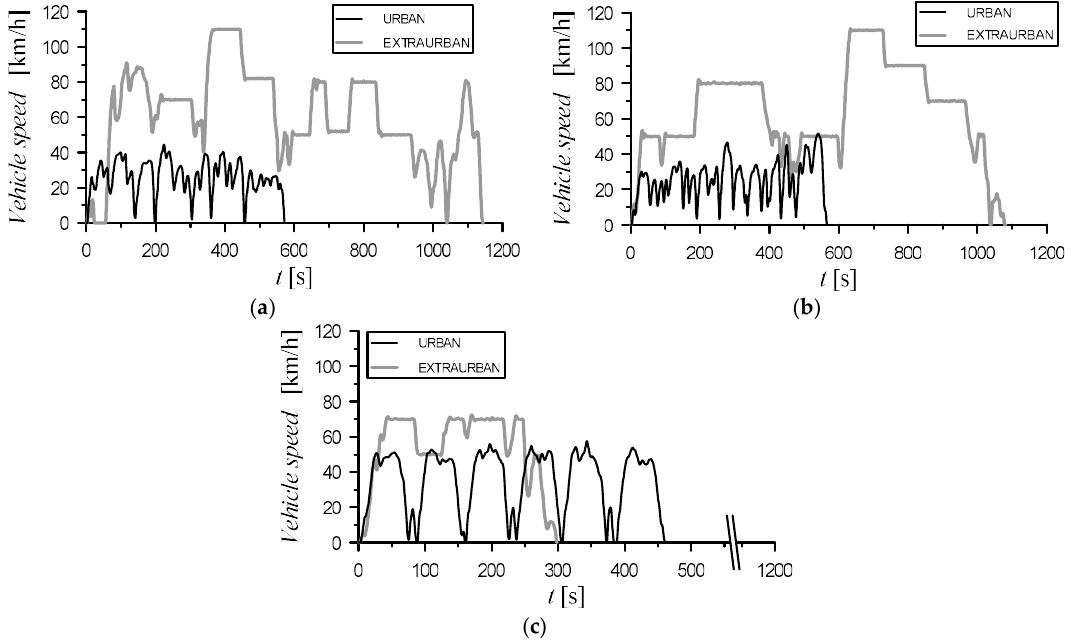
Figure 4. Examples of the velocity profiles followed in the tests at the different locations: ( a ) Valencia, ( b ) Ciudad Real and ( c ) Sierra Nevada.